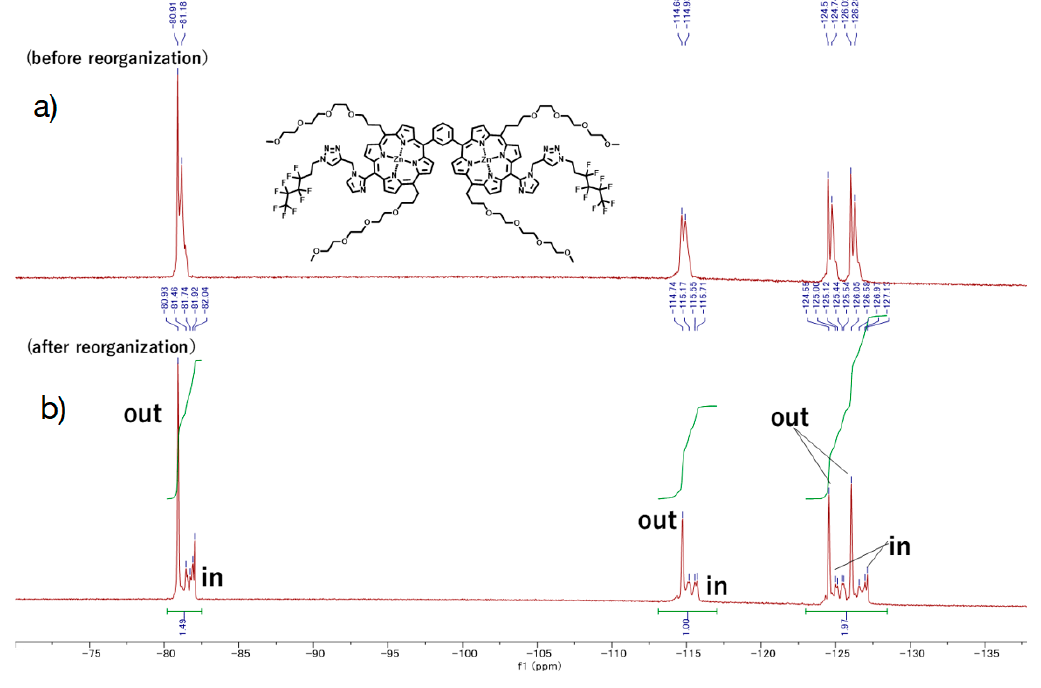
Figure 23. 19 F-NMR spectra (376.32 MHz, CDCl 3 , 298 K) of F9-GP1 . ( a ) before and ( b ) after reorganization.